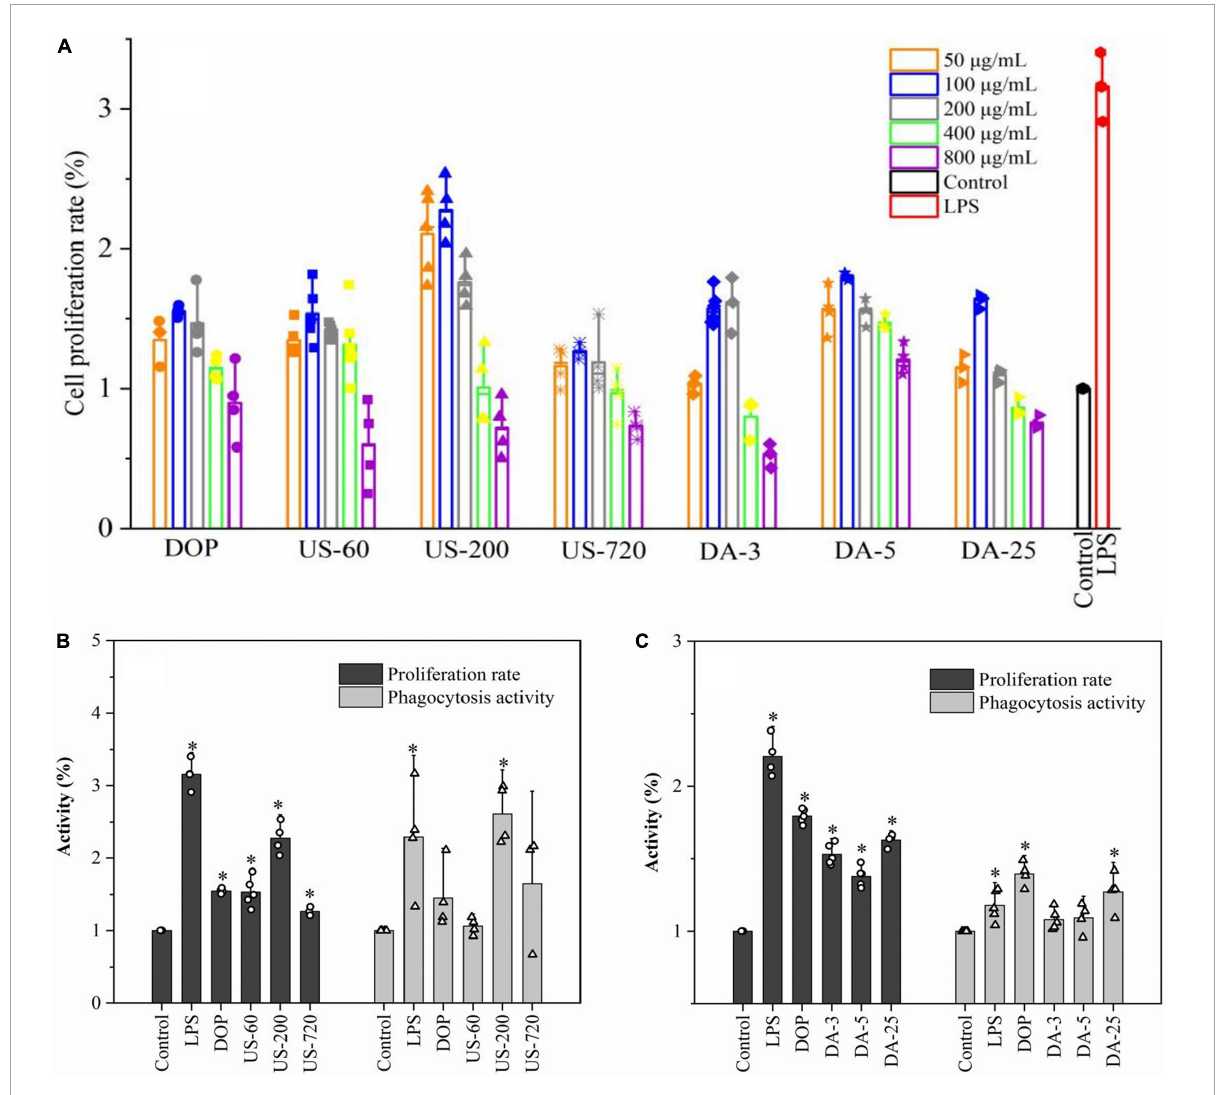
FIGURE3 Polysaccharide induced proliferation and phagocytosis of macrophages. (A) Determination of optimal concentration (50, 100, 200, 400, 800 µ g/ml). The proliferation and phagocytosis activities of ultrasonic (B) and de-acetylated (C) samples (100 µ g/ml). All data are representative of at least three independent experiments. ∗ p < 0.05 vs.